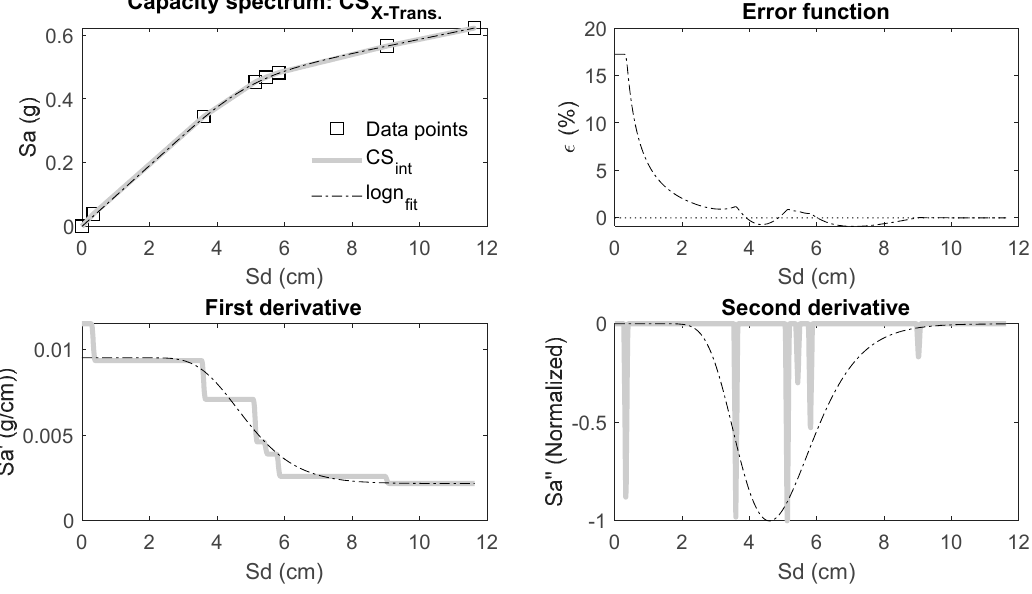
Figure 9. Parametric model fit in the X-direction.